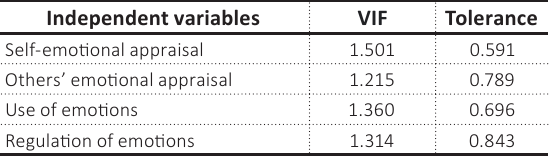
Table 2. VIF and tolerance values for independent variable dimensions Independent variables